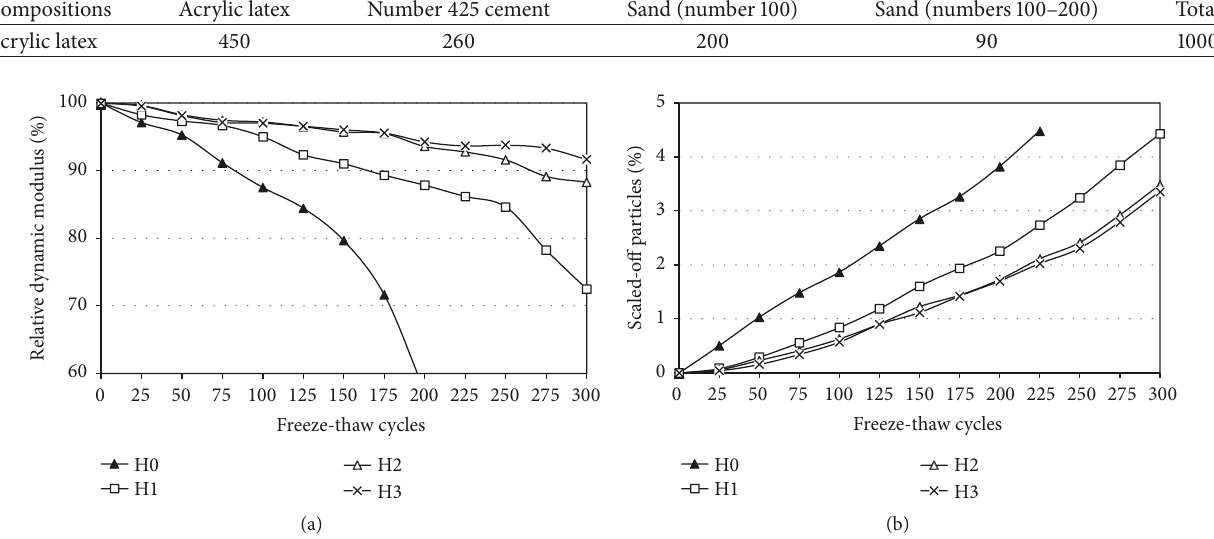
Figure 4: Portland cement concrete with dosages of air-entraining agents under freeze-thaw cycles: (a) relative dynamic modulus and (b) percentage of scaled-off mass.